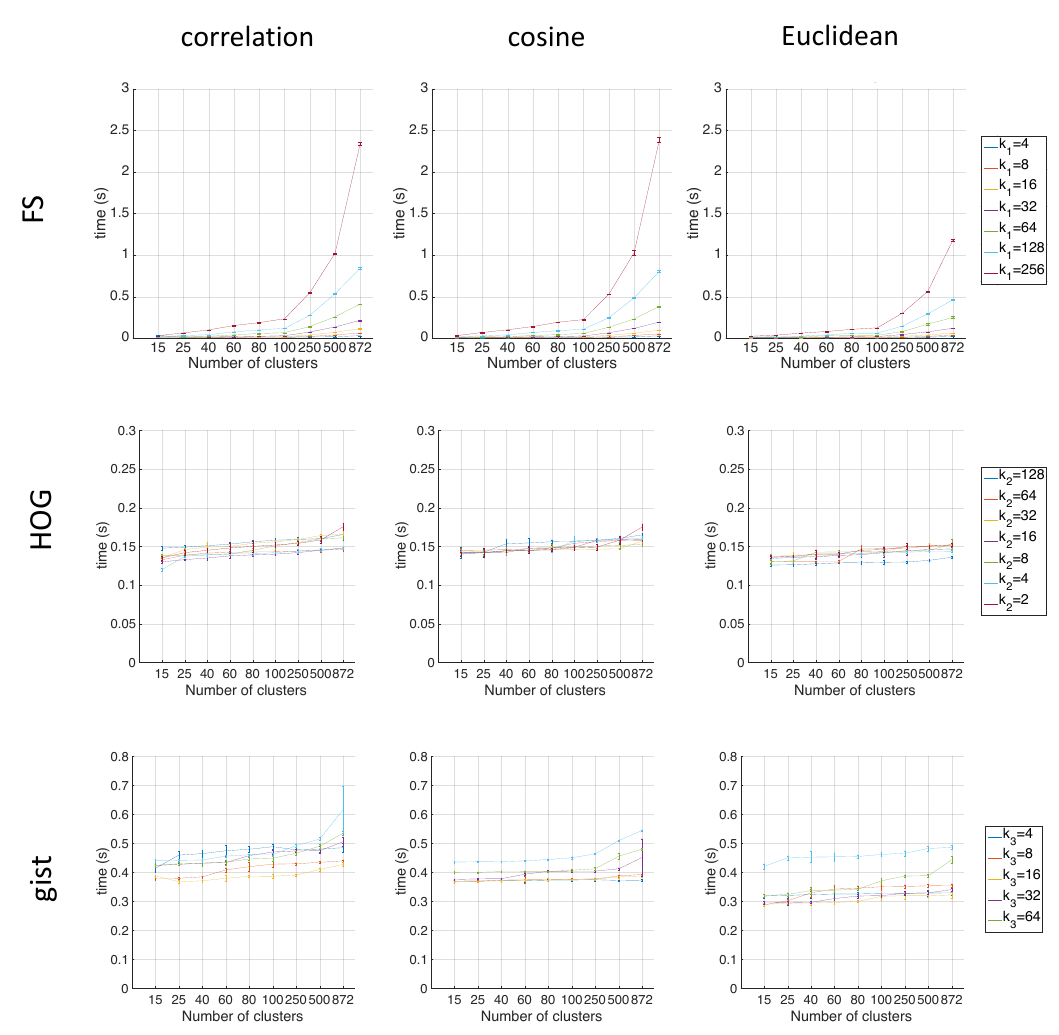
Figure 17. Results of the localization process with FS, HOG, and gist used to describe the representatives of the clusters and the test images: average computing time vs. number of clusters. Quorum V